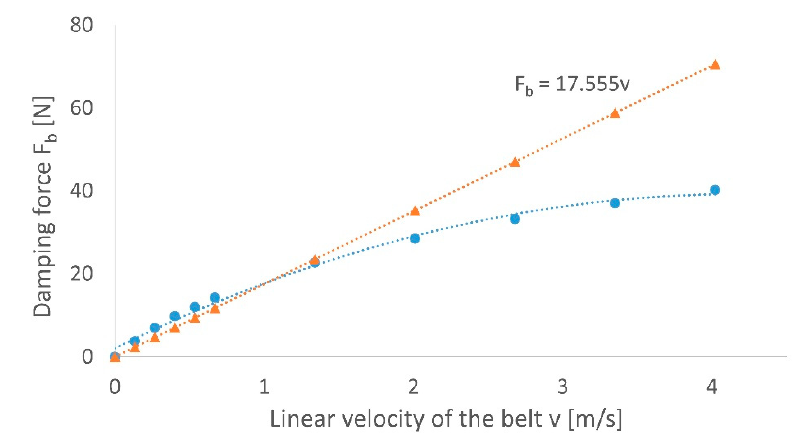
Figure 8. Modeling the coefficient of damping b TB for the toothed belt.